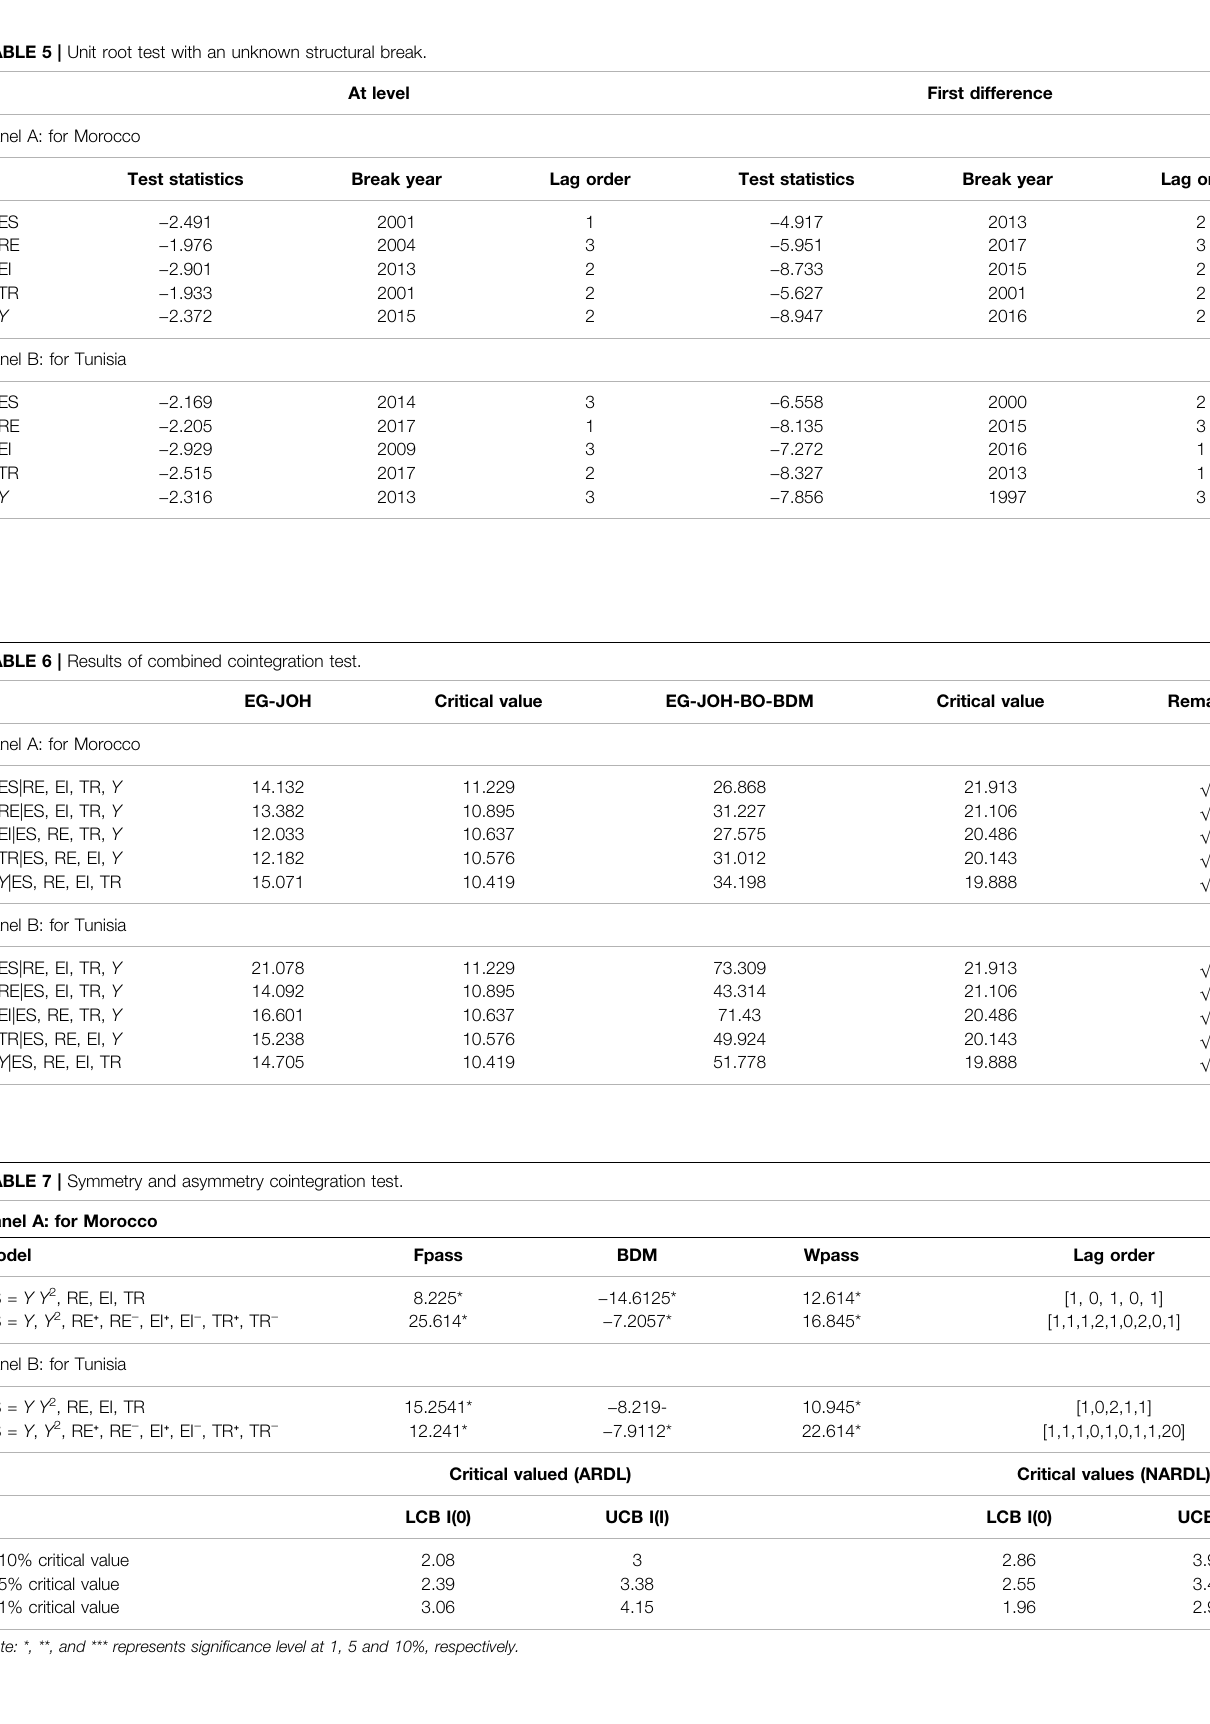
TABLE 5 | Unit root test with an unknown structural break.